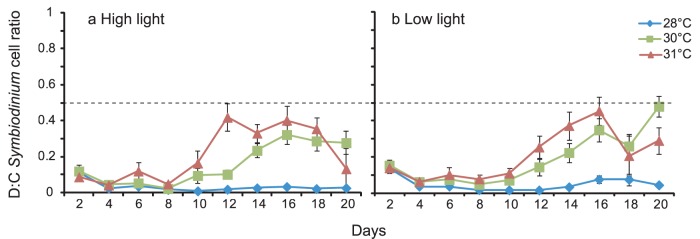
Change in Symbiodinium D∶C cell ratios (±1 SE) over time in Acropora tenuis juveniles at 28, 30, or 31°C in: (a) high light (390 µmol photons m−2 s−1), or (b) low light levels (180 µmol photons m−2 s−1).Dotted line represents equal proportions of Symbiodinium types D and C cells within the juveniles. Ratios closer to 1 are dominated by type D; ratios closer to 0 are dominated by type C. N = 20 per data point.